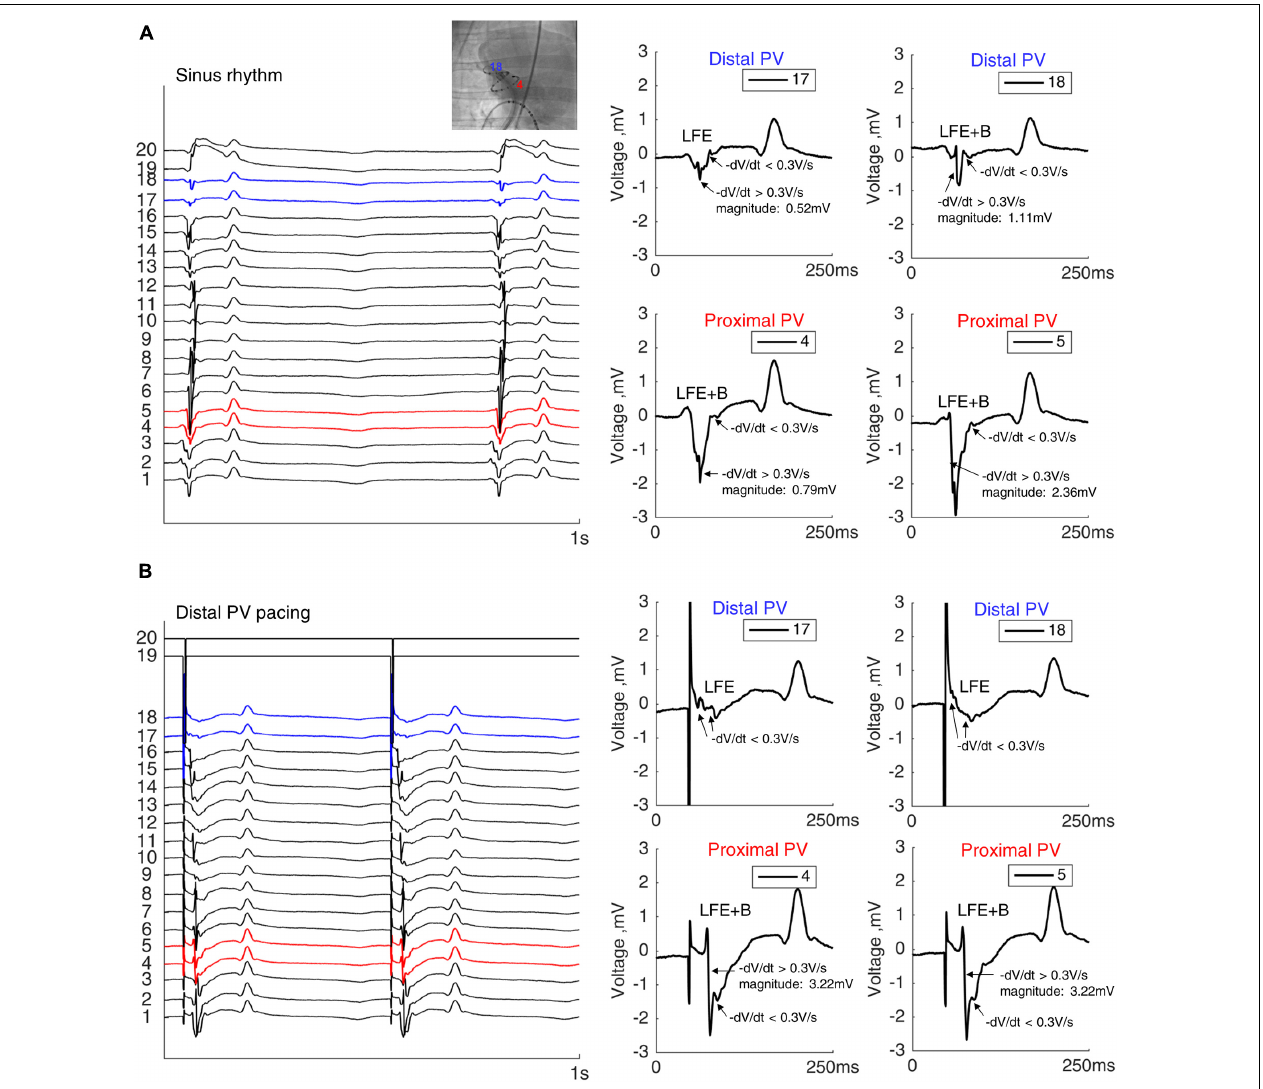
FIGURE 4 | Electrograms in the PV. Twenty unipolar PV electrograms during sinus rhythm (A) and distal PV pacing (B) in the same sheep. Two electrodes in both distal (blue) and in proximal (red) RPVs were analyzed after verifying the catheter position by fluoroscopy. Local fractionated electrograms with a bulk component (LFE+B) were more frequently observed in the proximal PV than the in distal PV. Note the remote ventricular activation after the PV electrograms. Bipolar stimulation in the distal RPV from electrodes 19 and 20.